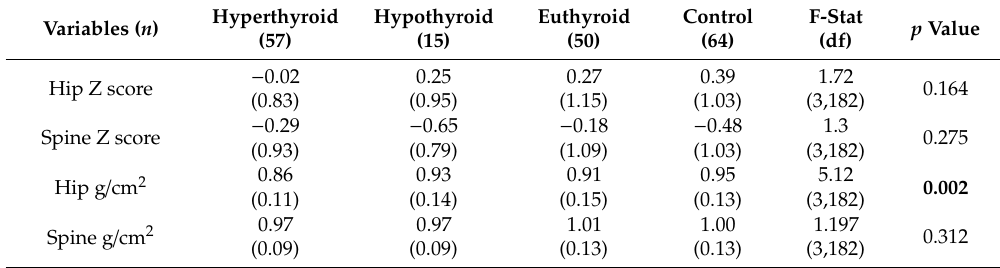
Table 12. ANOVA analysis. Comparison the mean of Z score for Hip and Spine, and bone density (g / cm 2 ) for Hip and Spine in between groups.